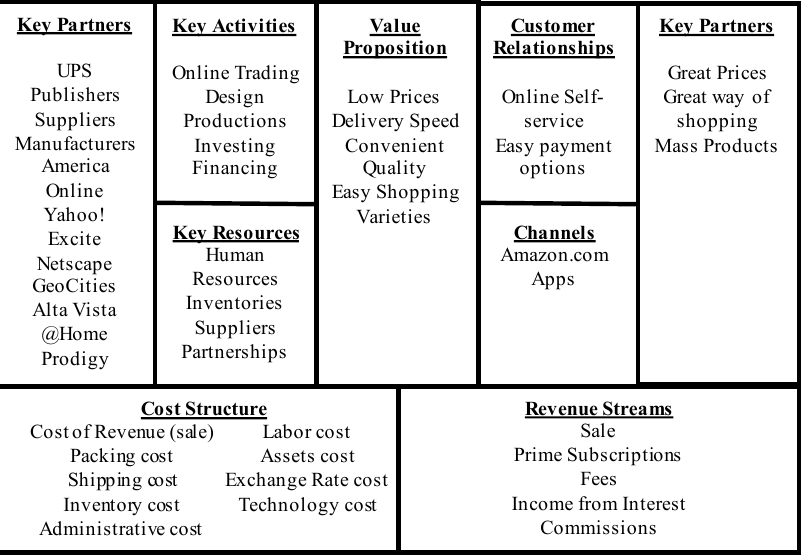
Fig. 7. Amazon Business